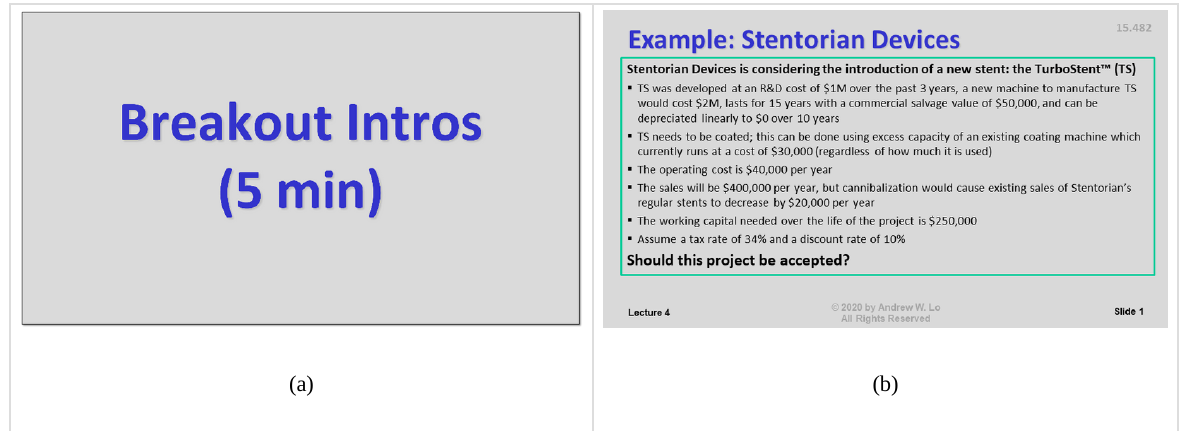
Figure 1. Breakout-room exercise slides for Andrew Lo’s Healthcare Finance course (15.482, Fall 2020) . Slide (a) announces the 5-minute ice-breaker session and slide (b) provides the exercise itself, on which teams of four to six students collaborated in a 10- minute breakout-room